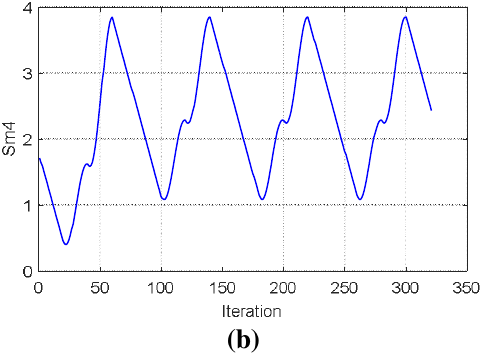
Fig. 15. Showing (a) Leg 1 in swinging phase. (b) The stability margin (cm) when leg1 is swing. vw x